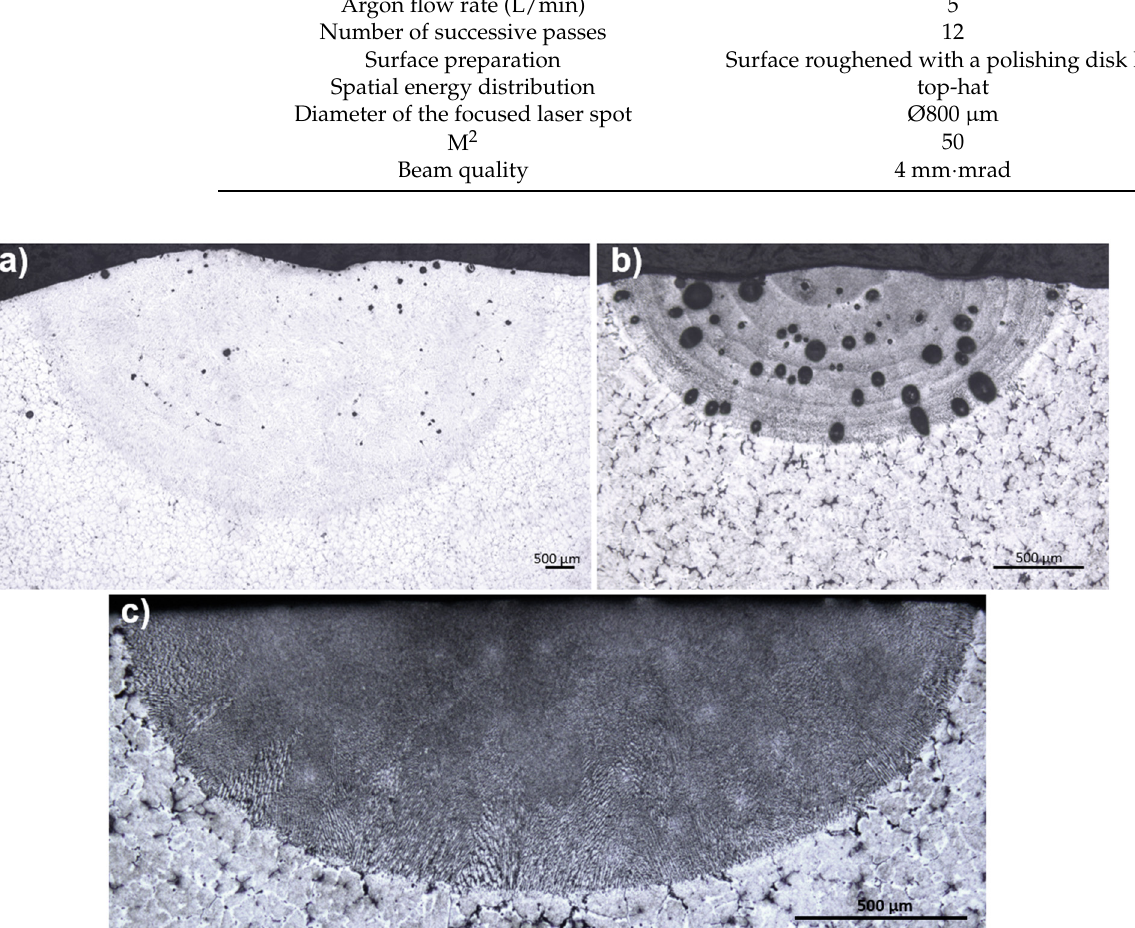
Figure 4. High-speed imaging camera images of hot vapor plume expansion during the laser welding of AlMg3. Figure 5a,b reveal the evolution of the hot vapor plume height in an interval of 27.5 ms for AlMg3 irradiated in the optimal experimental conditions. The substrate was, in all cases, on the bottom part of Figure 5a, the plume evolving on the orthogonal direction in respect to the substrate (z axis). It can be observed that the plume was stable with a mean value of 3.7 ± 1 mm. The expansion speed of the plume was 3.6 m/s in the case of AlMg3.